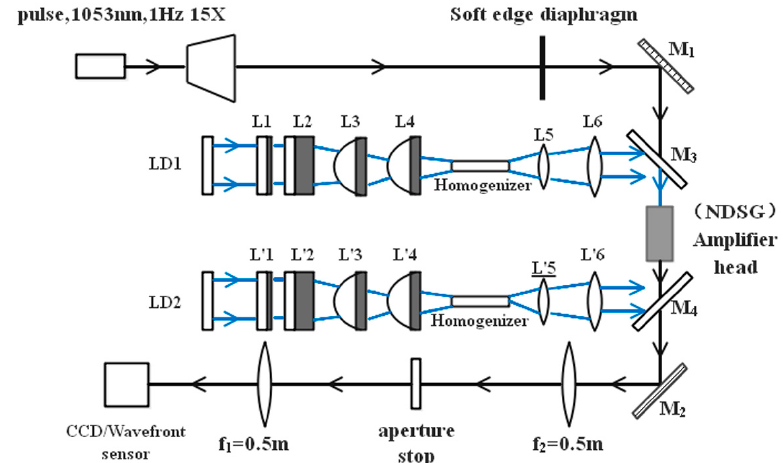
Figure 2. Layout of the LD-pumped NDSG rod laser amplification experiment. M1–M2: 45° mirrors; M3–M4: dichroic mirrors; f1–f2: 4F imaging system; L1–L6, L ′ 1–L ′ 6: lenses.